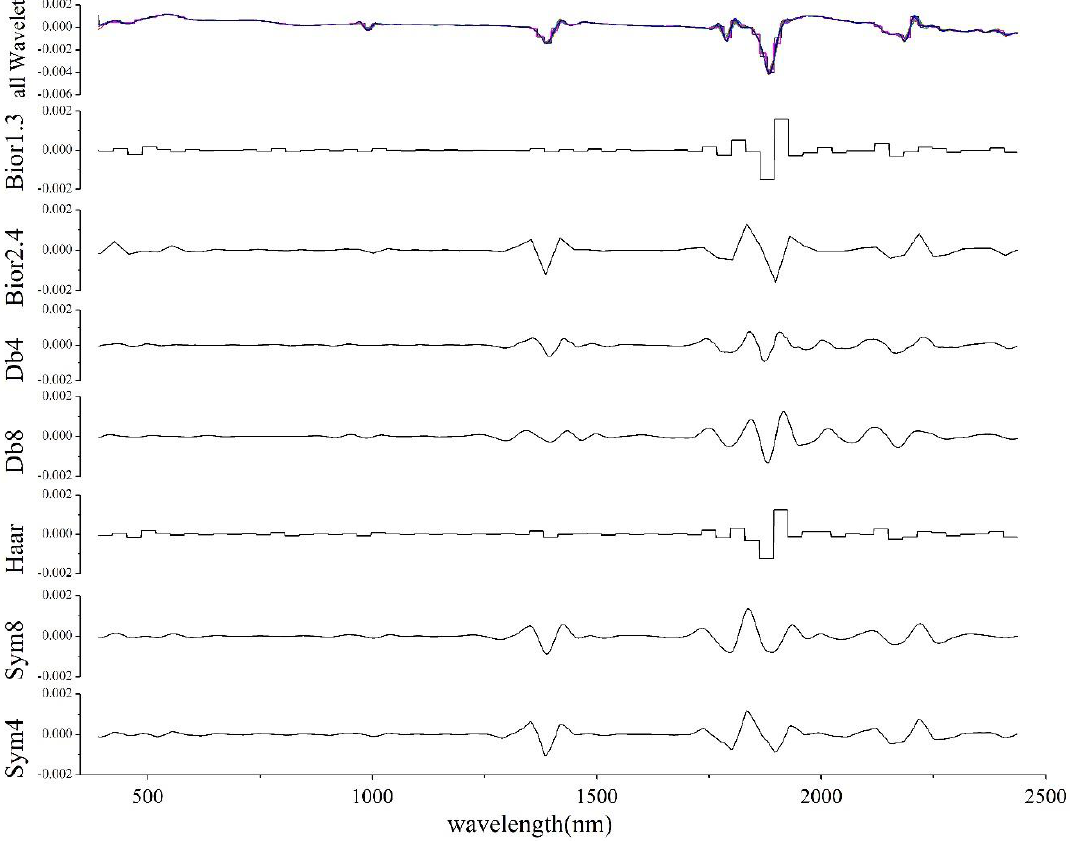
Figure 2. Single branches reconstructed from the sixth-level discrete wavelet transform (DWT) approximate coefficients and fourth-level detailed coefficients of different wavelet functions.